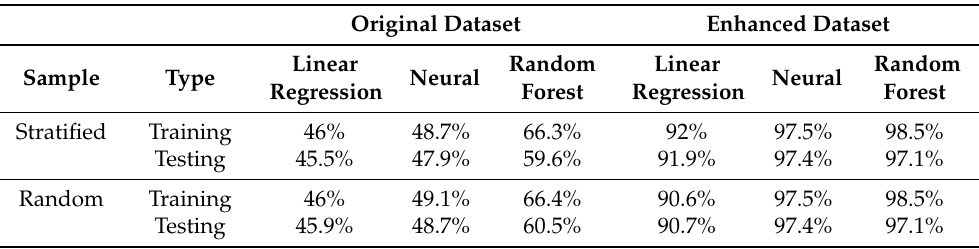
Table 4. Comparative accuracies of the training and testing models of different algorithms on both the original and enhanced dataset.